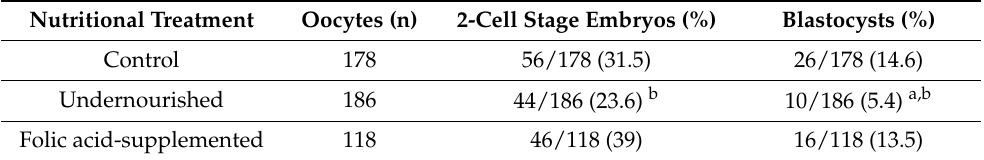
Table 1. Outcomes of in vitro fertilization (IVF) using sperm from lambs born to Control, Undernour- ished or Folic acid-Supplemented